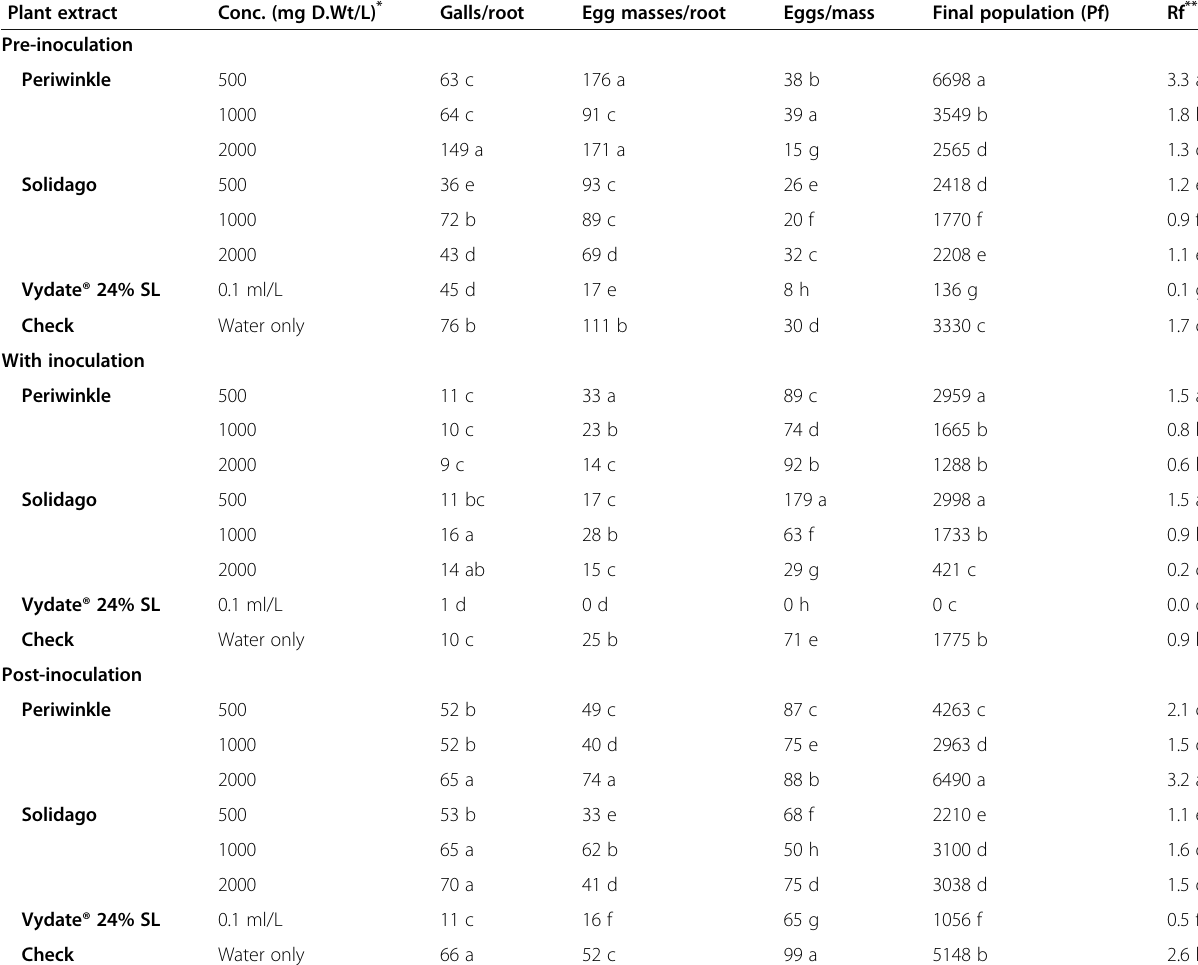
Table 6 Effect of soil drench of periwinkle and solidago aqueous extracts at different concentrations and application time on M. incognita infecting sunflower plants Plant extract Conc. (mg D.Wt/L) *